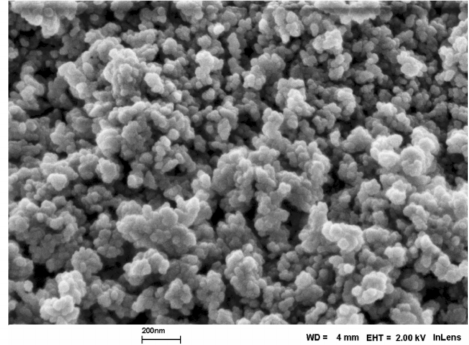
Figure 2. Scanning electron micrograph